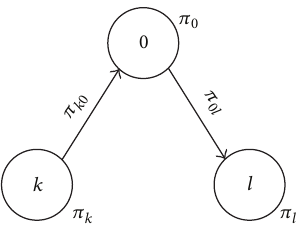
Figure 1: Model of pricing with nodal prices 𝜋 𝑘 , 𝜋 𝑙 , virtual node price 𝜋 0 , and transmission prices 𝜋 𝑘0 and 𝜋 0𝑙